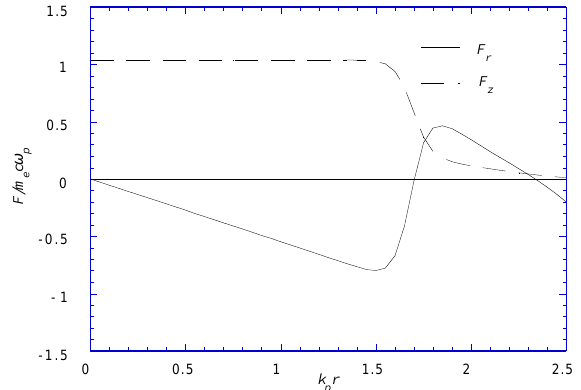
FIG. 2. (Color) Wakefield forces in acceleration phase of rarefied plasma wave, as a function of radius, from fluid code NOVO (Breizman et al.